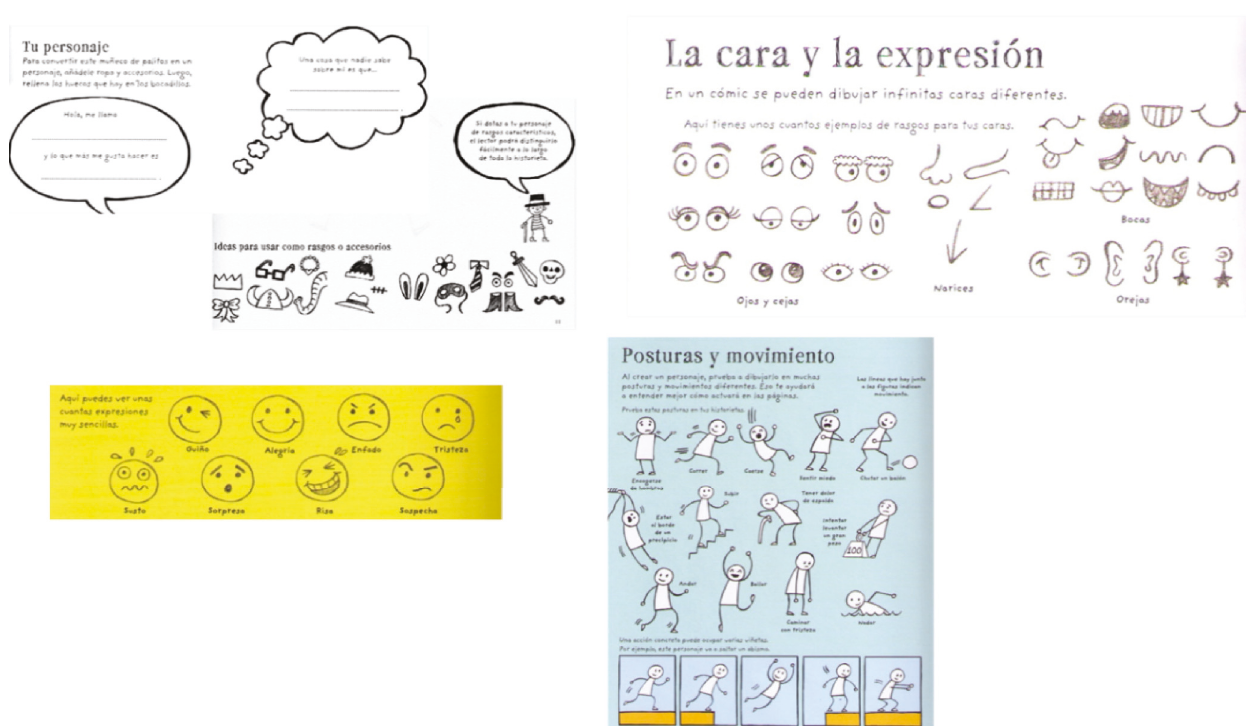
Figure 17: Material given to children to help them create comics (extracted from [48]).